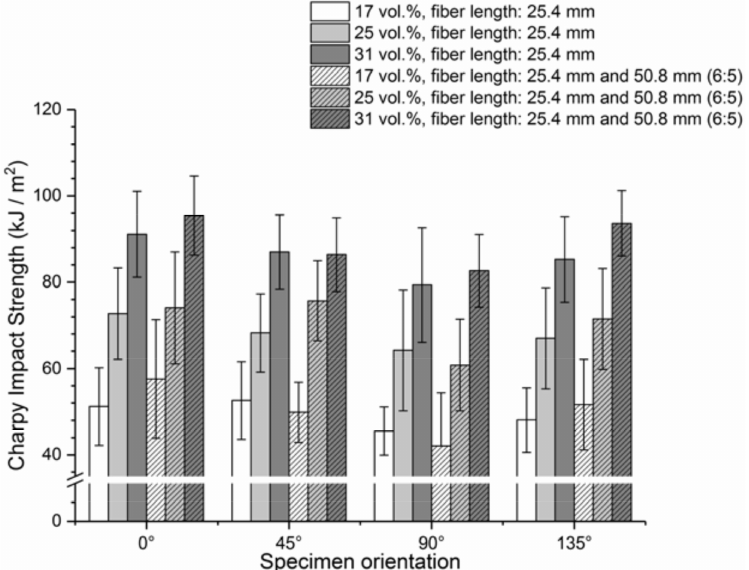
Figure 8. Charpy impact strength of different SMC materials considered in different directions with respect to the movement of the conveyor belt.